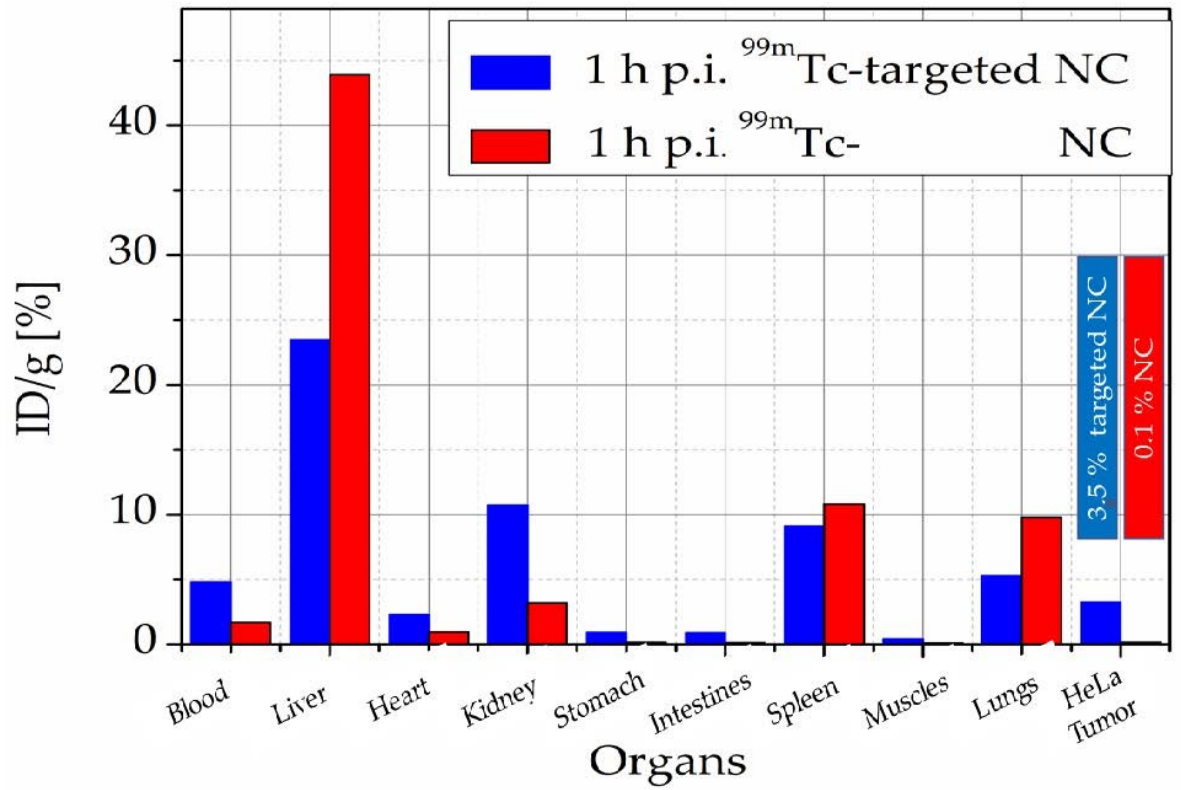
Figure 14. In vivo intake in 1 h in different organs and cancer for Nano4 (Dox) with and without F. A.